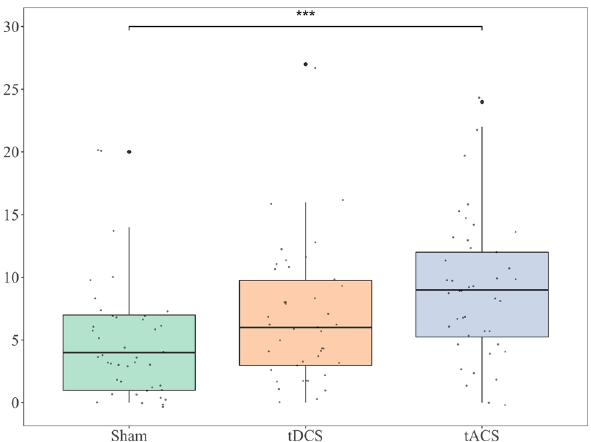
Figure 4. Average total number of errors (intrusion and repetition) during each stimulation type with vertical lines representing standard error. *p ≤ 0.05; ** p ≤ 0.01; *** p ≤